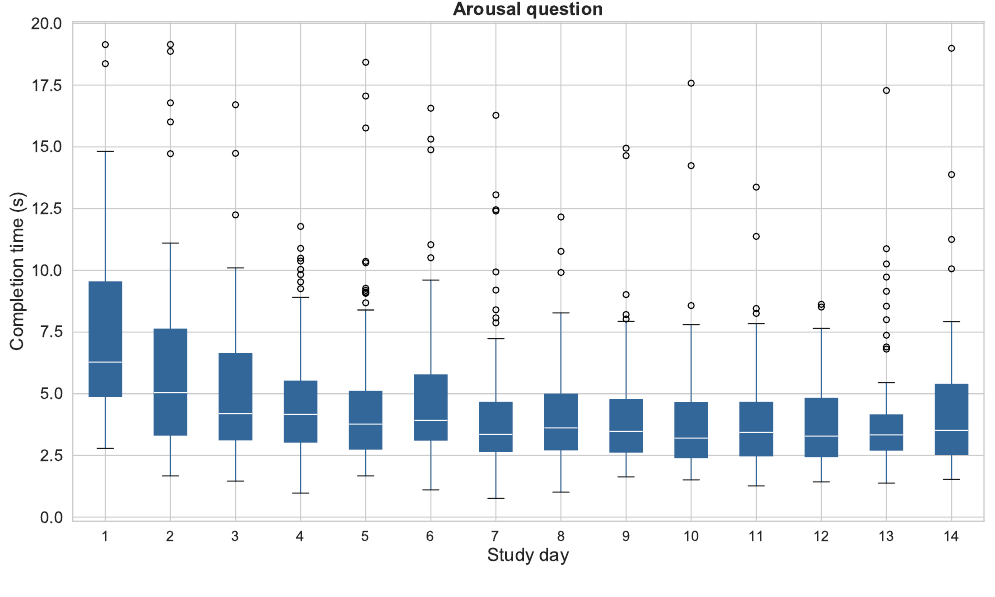
Figure 10. Completion times of the questionnaires per day of study for the arousal question. Times over 300 s have not been